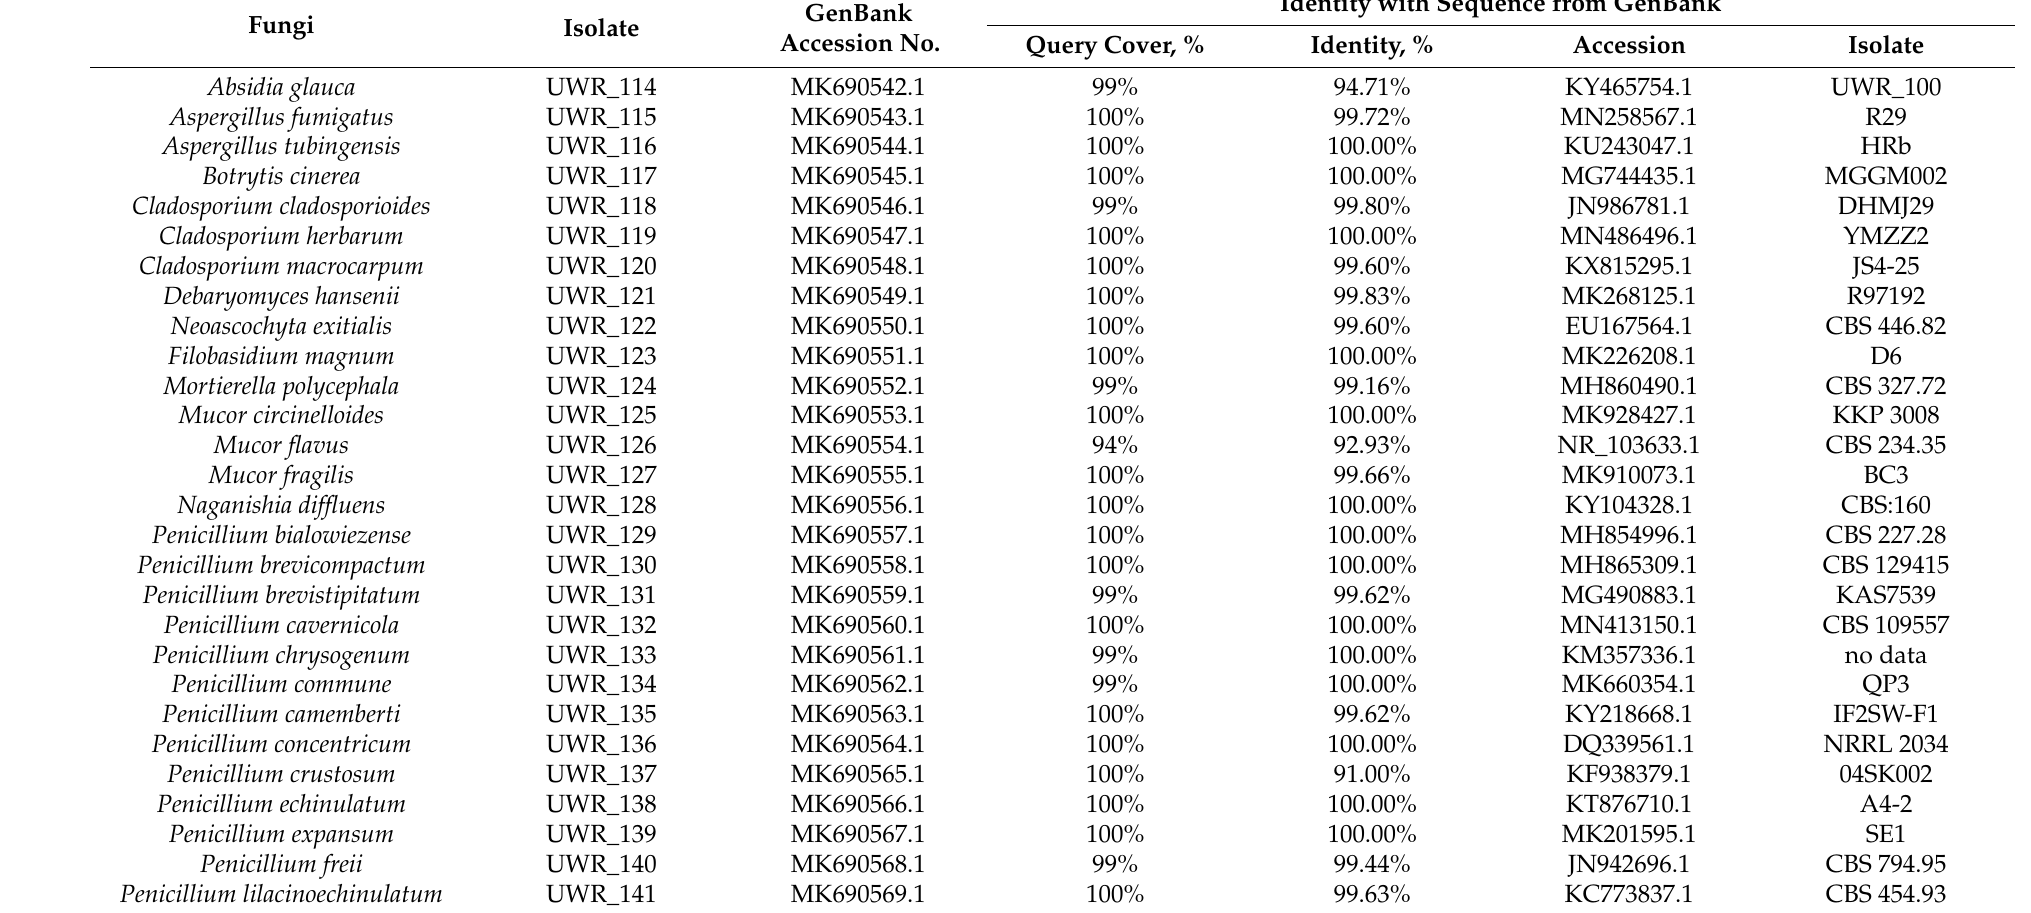
Table A1. BLAST analysis of rDNA ITS of culturable aeromycota isolated during research in the underground hibernation sites of the Nietoperek bat reserve and/or present close to hibernating Myotis myotis . All E values were